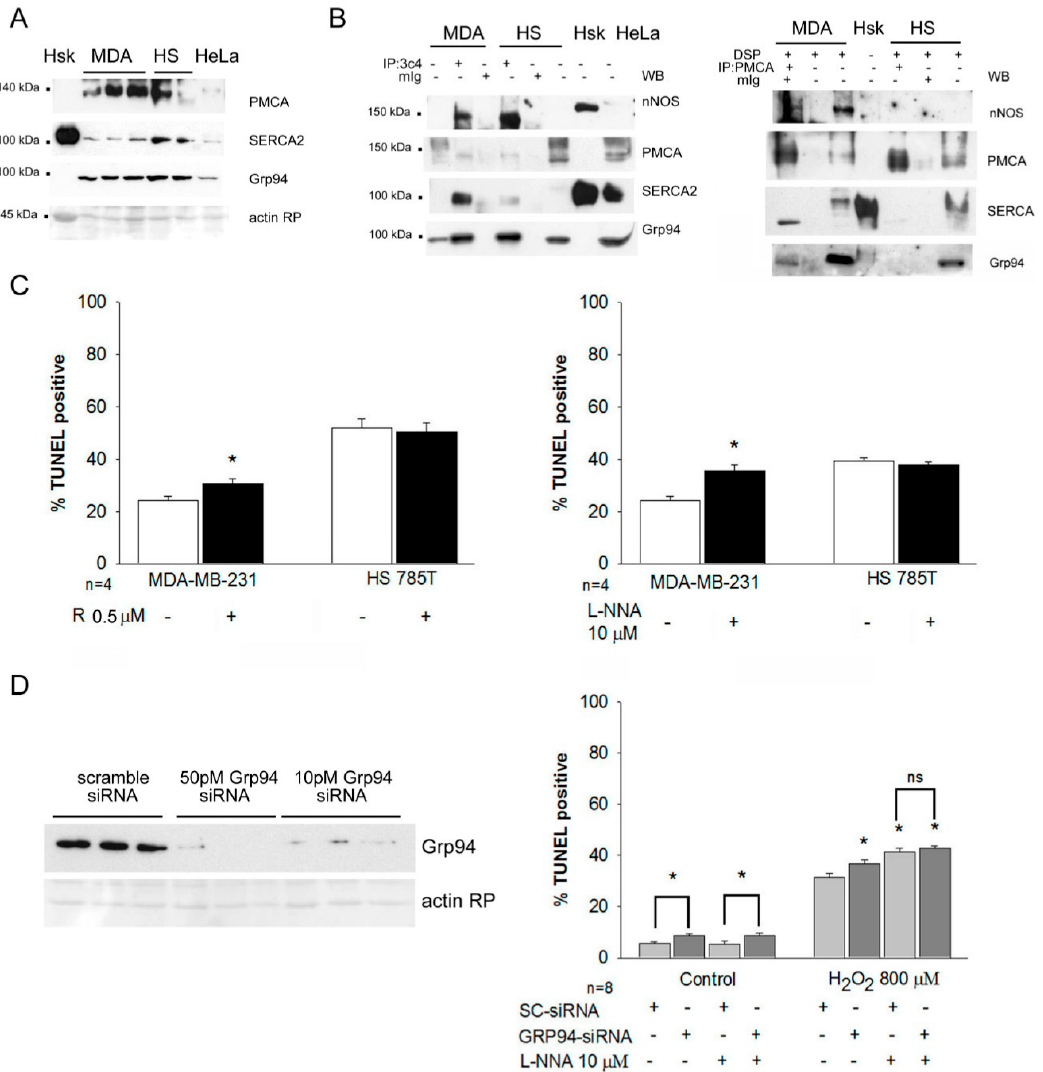
Figure 4. Grp94 interaction with Ca 2+ -handling proteins and nNOS, and cytoprotection in breast cancer cell lines. ( A ) Representative Western blots of whole homogenates from human skeletal muscle (Hsk) and of lysates of MDA-MB-231 (MDA), HS578T (HS) and HeLa cells tested with antibodies for PMCA, SERCA2 and Grp94. Red Ponceau staining of the blot at the level of actin was used for normalization. ( B ) Left panels: Representative Western blots of MDA and HS lysates (30 µg) and immunoprecipitates (IP, from 100–150 µg of lysate) using anti-Grp94 3C4 monoclonal antibody or non-immune mouse G immunoglobulins (mIg) tested for nNOS, PMCA and SERCA2 co-immunoprecipitation. Human skeletal muscle (Hsk) and HeLa cell lysates were loaded for reference. Right panels show reverse IP with anti-PMCA antibodies performed on lysates obtained after culture chemical cross-linking with DSP. ( C ) Histograms represent the percentage of TUNEL-positive nuclei of MDA-MB-231 and HS578T cells after exposure to hydrogen peroxide, with or without addition of radicicol (R) for 5 h ( A ) or L-NNA for 16 h ( B ) at the indicated dosages. Values were calculated on at least 100 cells for each slide. n indicates the number of slides analyzed. Student’s t -test, * p < 0.01. ( D ) Left panel: Representative Western blot of lysates of MDA-MB-231 cells 72 h after transfection with two different siRNA concentrations tested with antibodies for Grp94. Red Ponceau staining of the blot at the level of actin was used for normalization. Right panel: Histograms represent the percentage of TUNEL-positive nuclei detected in scramble (SC) and Grp94 siRNA transfected MDA-MB-231 cells, in growing conditions and after exposure to hydrogen peroxide, without or with addition of LNNA for the last 16 h at the indicated dosage. ANOVA, * p < 0.001.